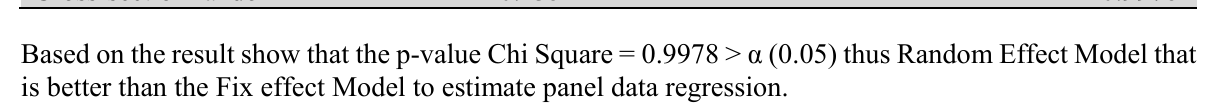
The results of Hausman test Test